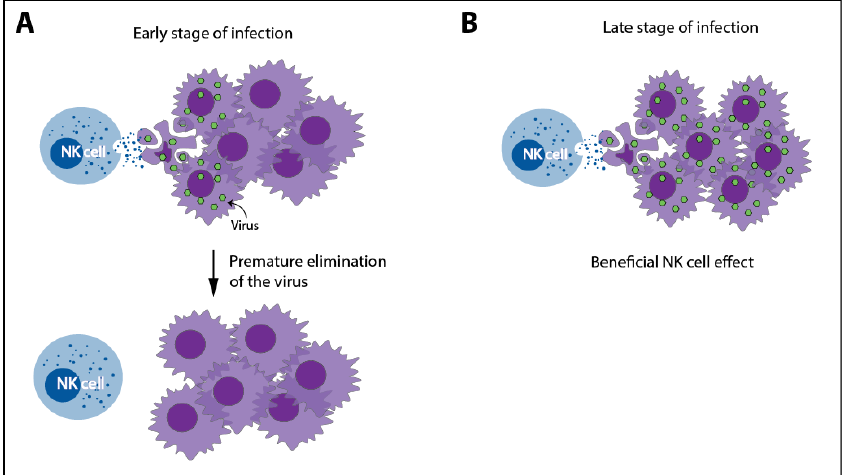
Figure 4. A dual role of NK cells in oncolytic virus therapies. Due to their ability to recognize and kill virus-infected cells, NK cells can cause a premature elimination of the virus, limiting its efficacy ( A ). However, thanks to this ability, NK cells can also enhance the clinical response by eliminating tumor cells in later stages of oncolytic virus (OV) therapy ( B ).